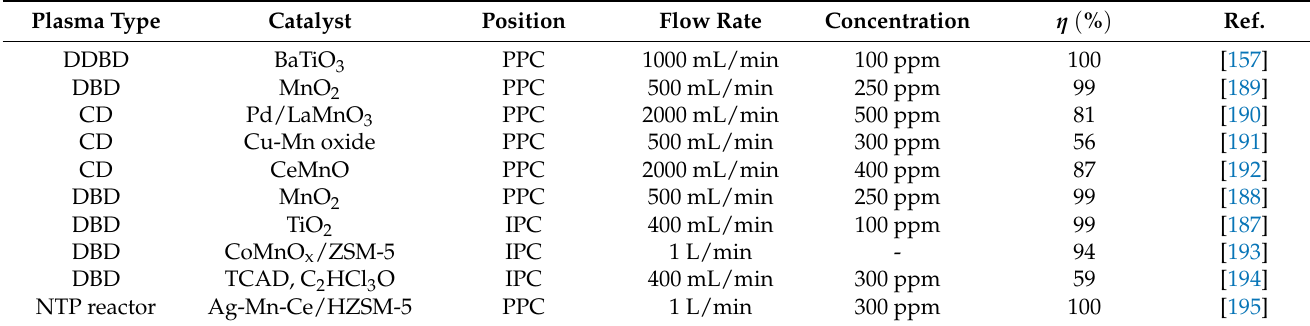
Table 3. Summary of the plasma-catalytic TCE